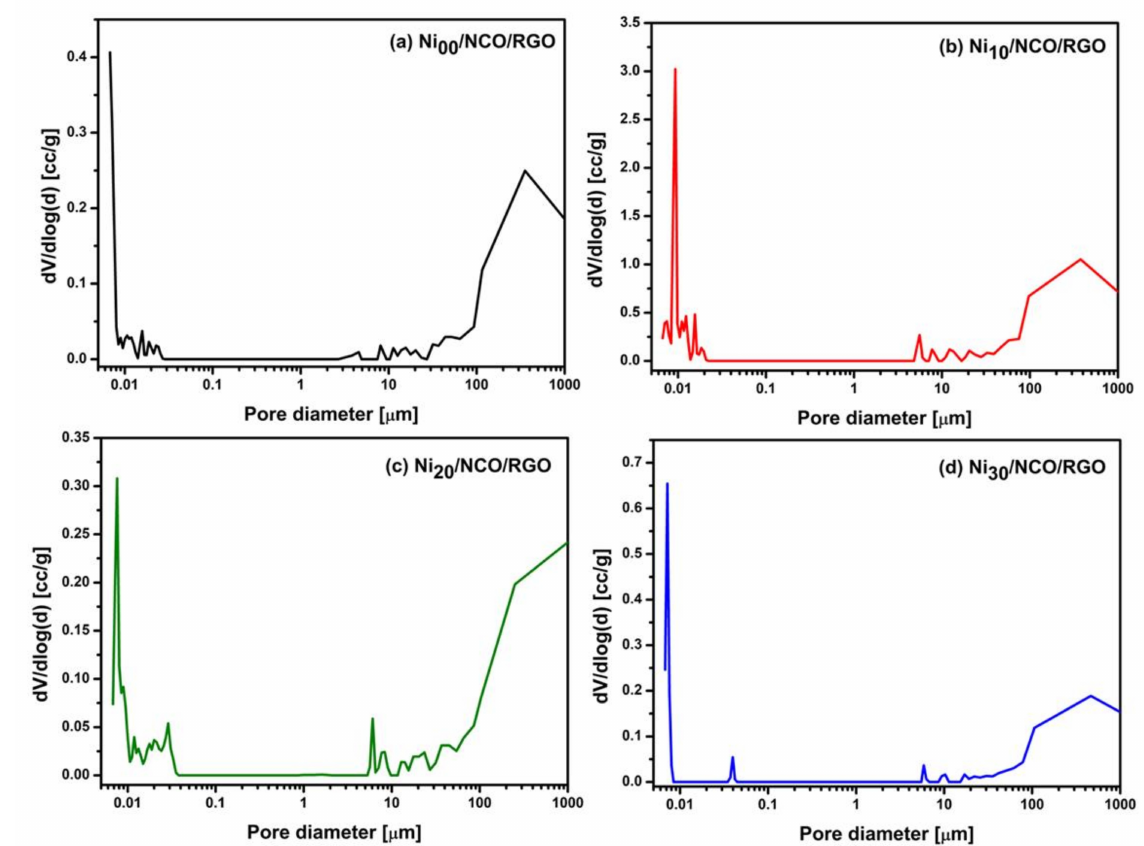
Figure 4. Pore size distribution curves of various Ni/NCO/RGO